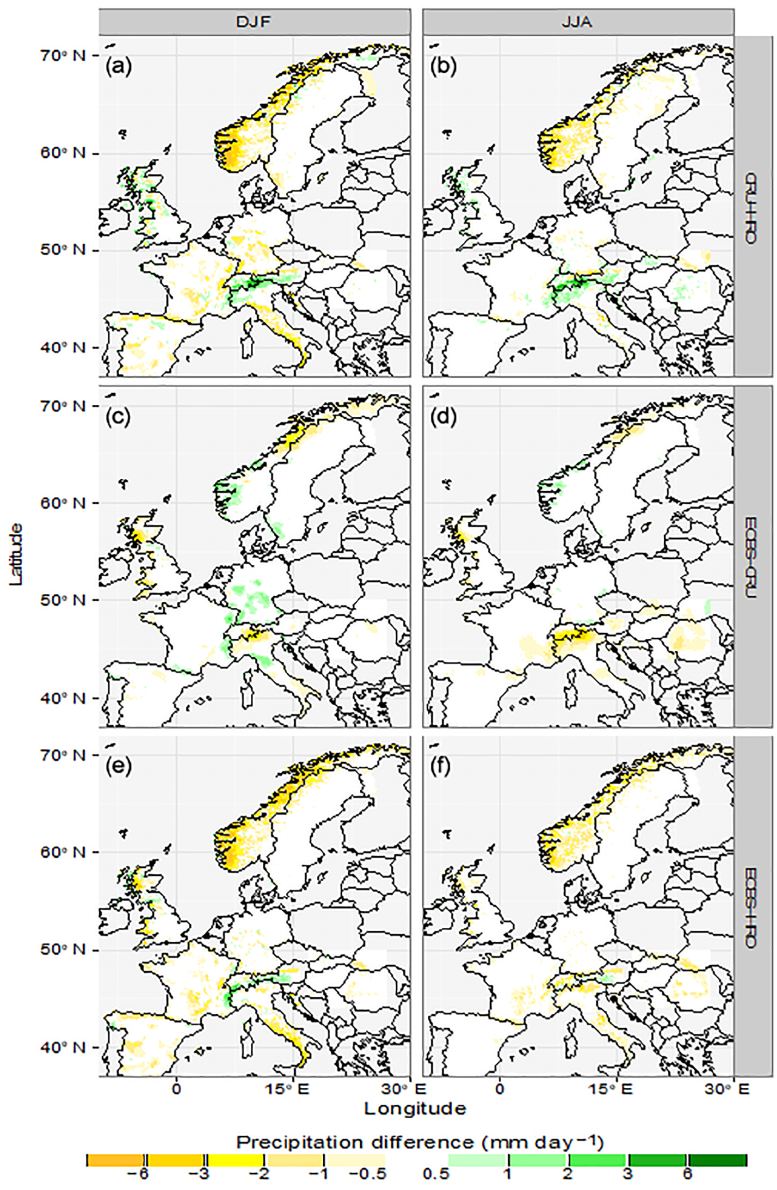
Figure 7. Seasonal average precipitation differences for December–January–February (DJF; a, c, e ) and June–July–August (JJA; b, d, f ) between CRU and HRO (a, b) , E-OBS and CRU (c, d) , and E-OBS and HRO (e, f) . Acronyms are as follows: CRU is the Climatic Research Unit of the University of East Anglia; E-OBS is the ENSEMBLES daily gridded observational dataset; HRO indicates high-resolution observations (based on a network of local